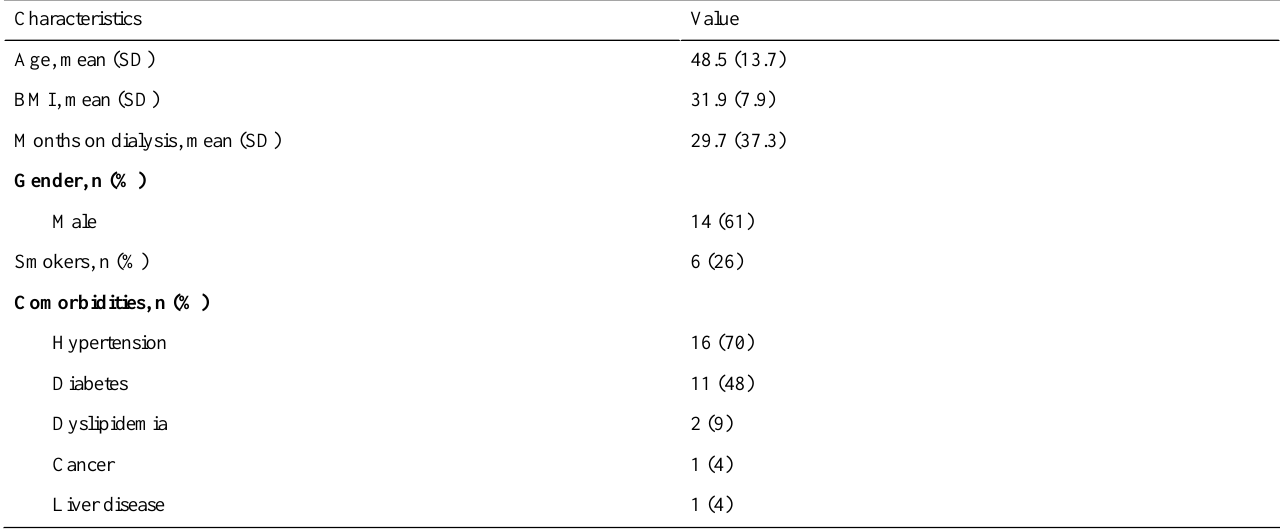
Table 1. Demographic and baseline characteristics of the sample